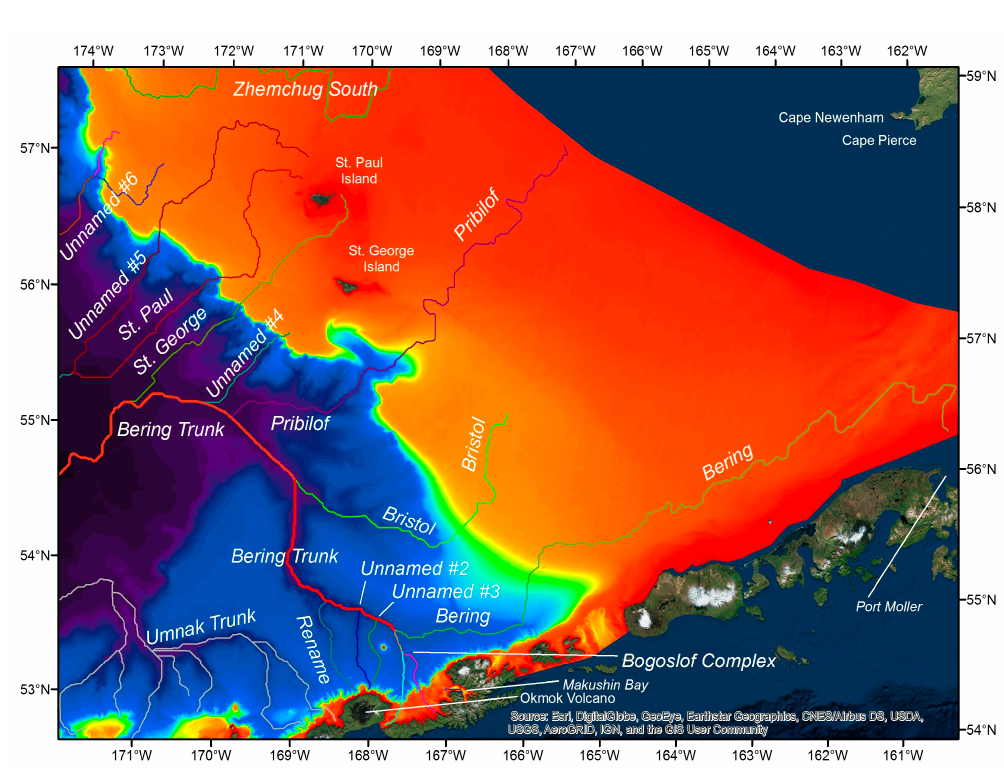
Figure 7. Thalwegs of the Bering Canyon area of the eastern Bering Sea slope. Table 2. Bering Canyon names and metrics described from south to north.